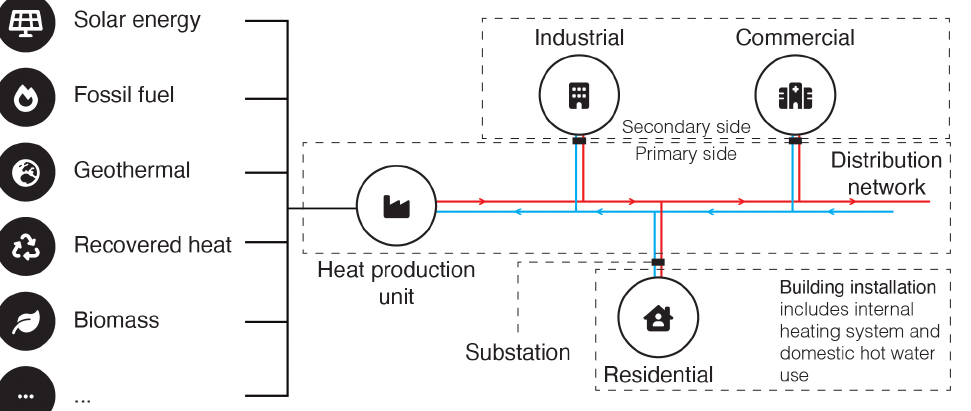
Figure 2. Illustration of a district heating network.